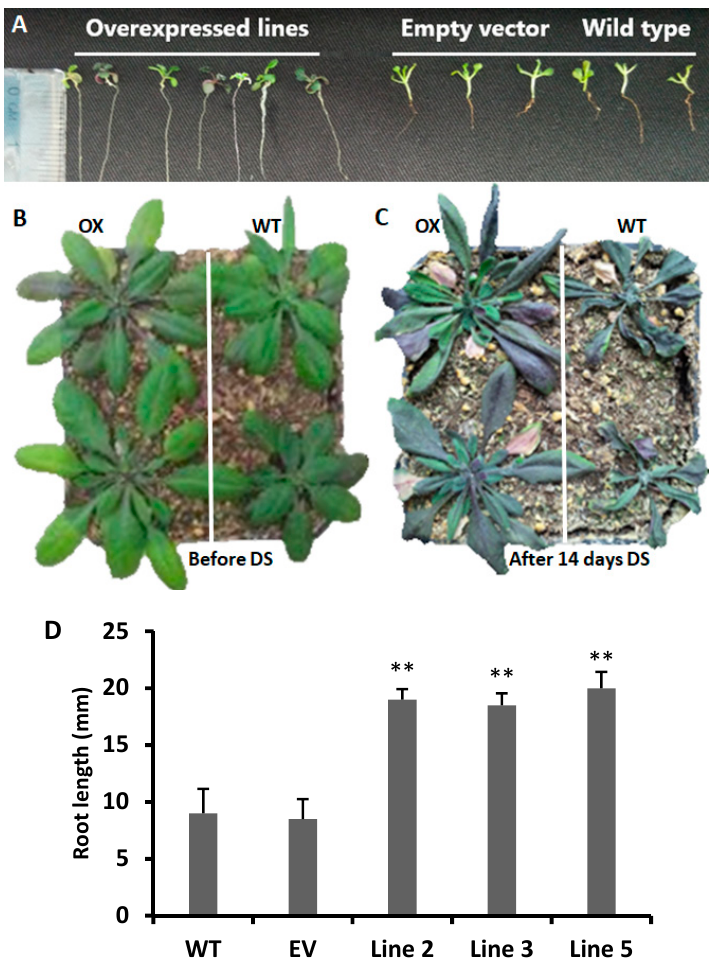
Figure 2. Drought stress effects on transgenic and wild type plants. ( A ) Roots of overexpressed lines, empty vector, and wild type plants after 14 days of polyethylene glycol (PEG-6000) stress. ( B ) Before drought stress (DS), overexpressed (OX), and wild type (WT) plants. ( C ) OX and WT plants after 14 days of drought stress. ( D ) Root length of WT and empty vector (EV) plants compared to the transgenic lines under PEG stress. A Students t -test was used to compare the CYT-OX and WT plants at ** p < 0.01. Each value is a mean of three replicates.